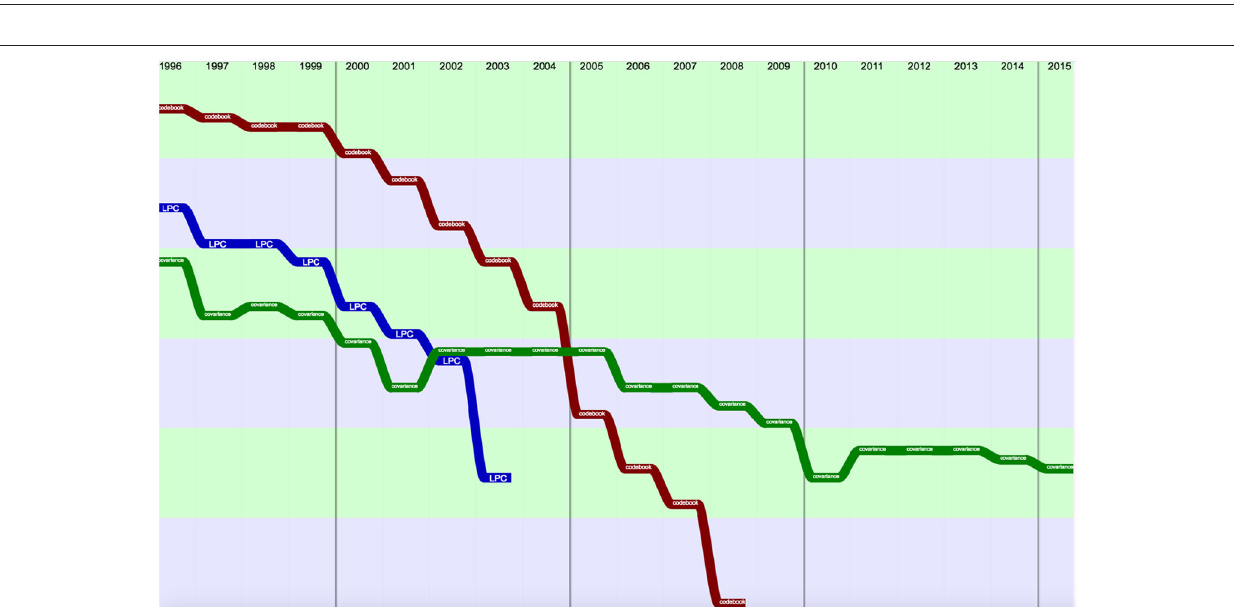
FIGURE 4 | Topics losing popularity (raw ranking, according to Frequency with